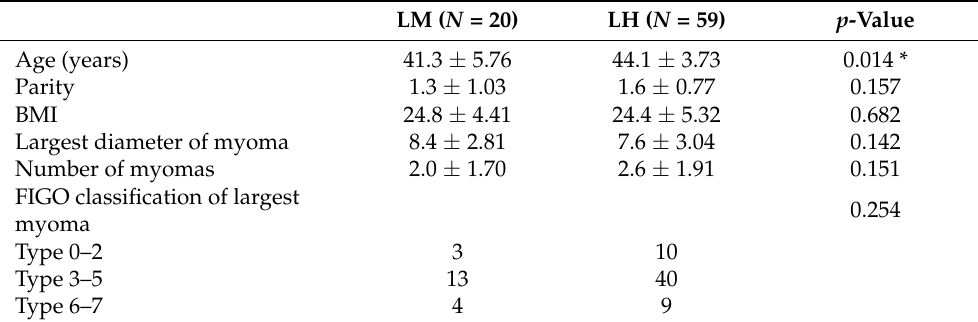
Table 1. Baseline data.